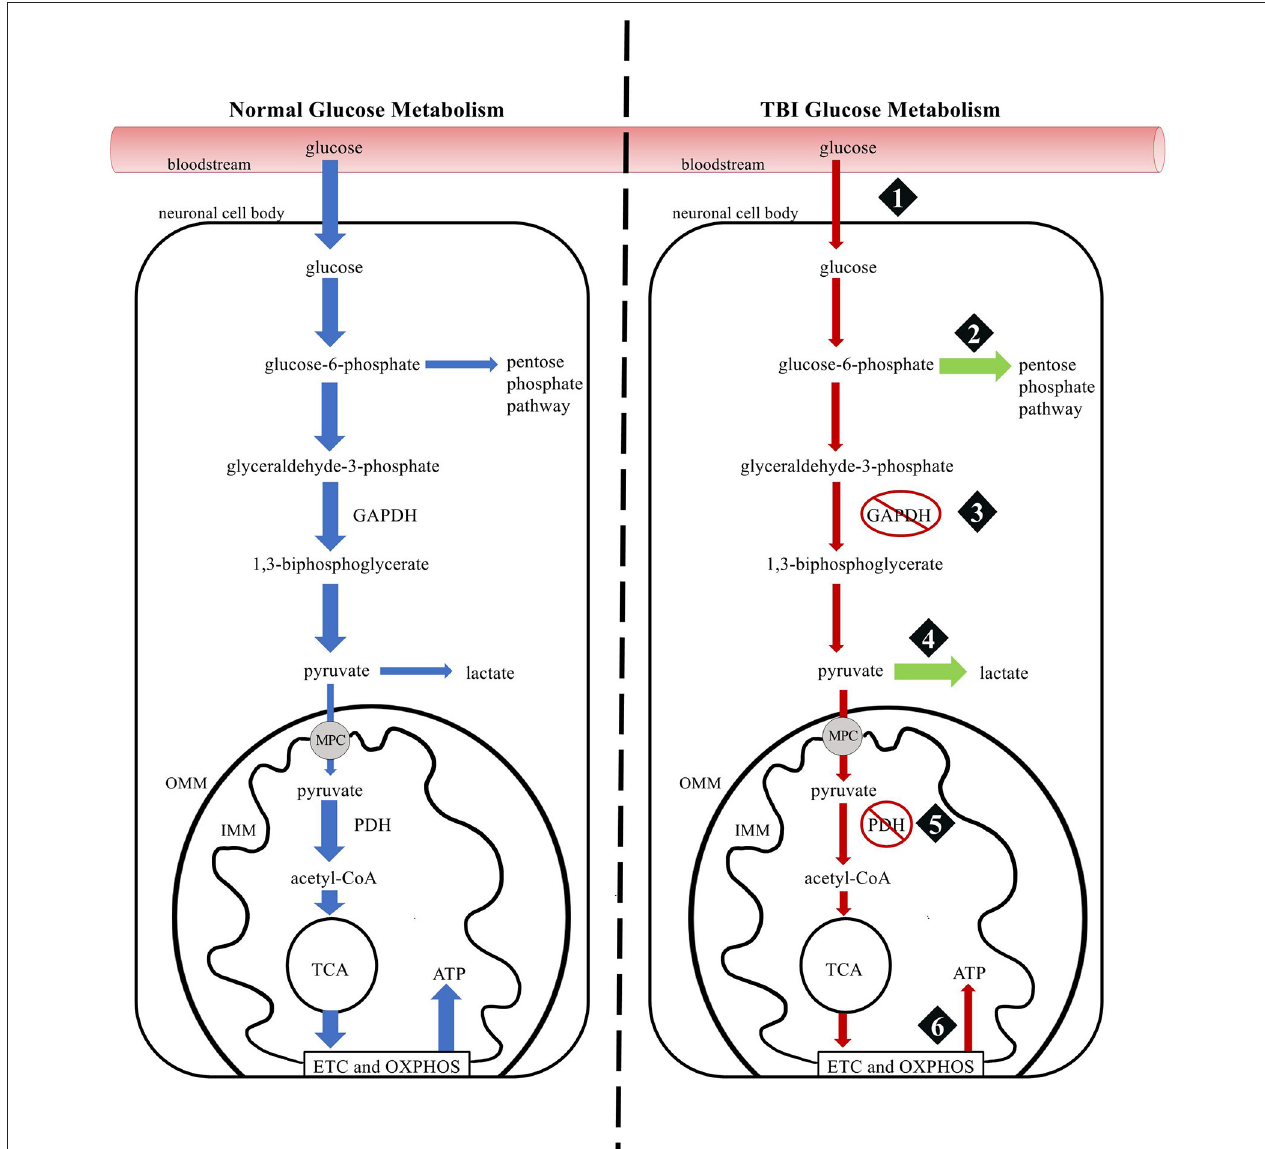
FIGURE 2 | Comparison of glucose metabolism in normal and TBI physiology. (1) A TBI triggers a transient increase in glucose uptake followed by a prolonged decrease in glucose metabolism. (2) Following a TBI, a larger portion of glucose-6-phosphate is shunted to the Pentose Phosphate Pathway to generate protective and reparative molecules. (3) Glyceraldehyde-3-phosphate dehydrogenase is slowed, decreasing tricarboxylic acid cycle intermediates. (4) Lactate production increases in astrocytes so that lactate can be shuttled to energy-deficit neurons. (5) The pyruvate dehydrogenase complex is inhibited, decreasing tricarboxylic acid cycle intermediates. (6) The function of the electron transport chain and oxidative phosphorylation is impaired, resulting in less ATP production. GADPDH, glyceraldehyde-3-phosphate dehydrogenase; MPC, mitochondrial pyruvate carrier; PDH, pyruvate dehydrogenase complex; TCA, tricarboxylic acid cycle; ETC, electron transport chain; OXPHOS, oxidative phosphorylation; ATP, adenosine triphosphate; OMM, outer mitochondrial membrane; IMM, inner mitochondrial